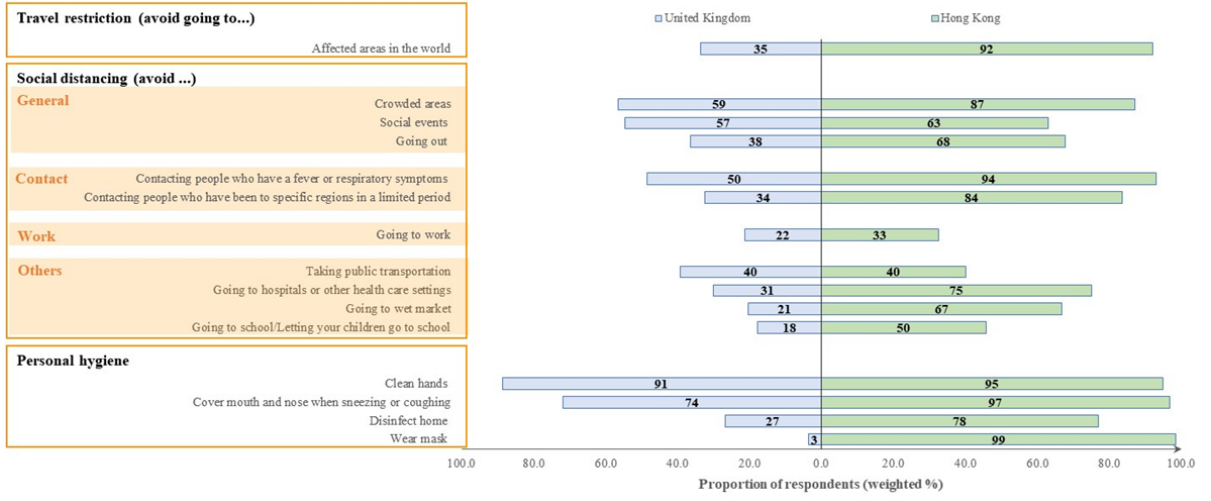
Sociodemographic factors were associated with the three social distancing measures (Table S3 in Multimedia Appendix 1; Table 3). The UK respondents were significantly less likely than their Hong Kong counterparts to adopt social distancing measures (Table S3 in Multimedia Appendix 1, OR 0.08-0.53, P <.001; Table 3, aOR 0.08-0.70, P <.001). When adjusting for differences between settings, general measures were less likely to be adopted by male respondents (aOR 0.82; 95% CI 0.71-0.95)